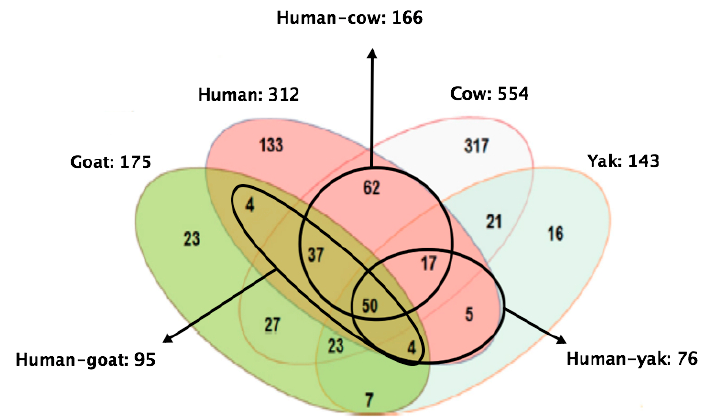
Figure 5. Shared and uniquely identified and quantified proteins in humans, cows, goats, and yaks. Adapted from Lu et al., 2016 [61].